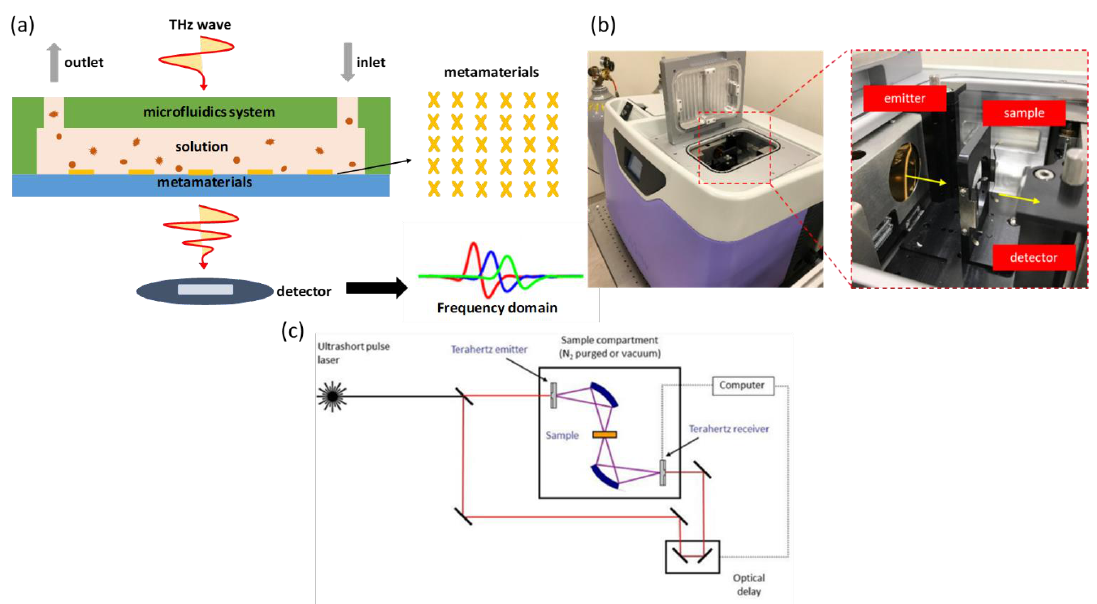
Figure 3. ( a ) Illustration of detection mechanism; the THz radiation penetrates the entire cartridge. ( b ) Internal setup in the chamber (TeraPulse 4000). ( c ) Setup of optical components inside the